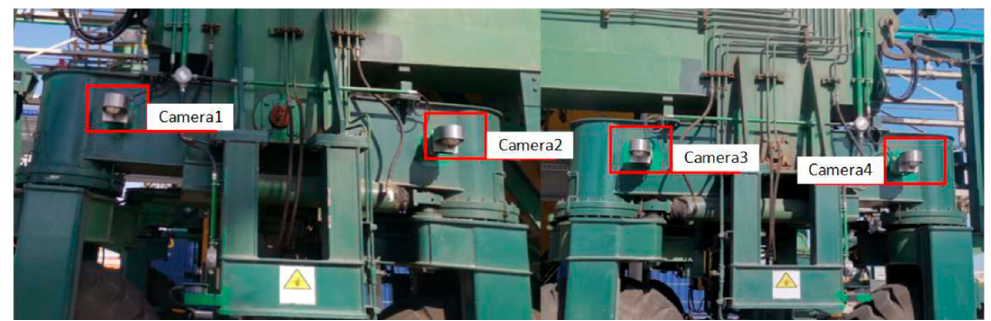
Figure 14. Camera installation drawing.